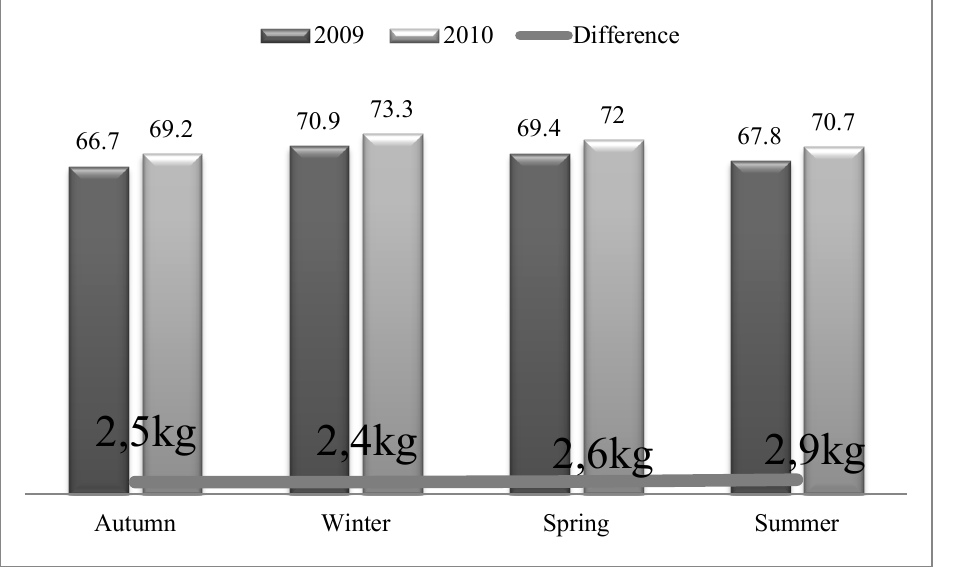
Figure 4. The mean body weight and annual differences of participants in 2009 and 2010.